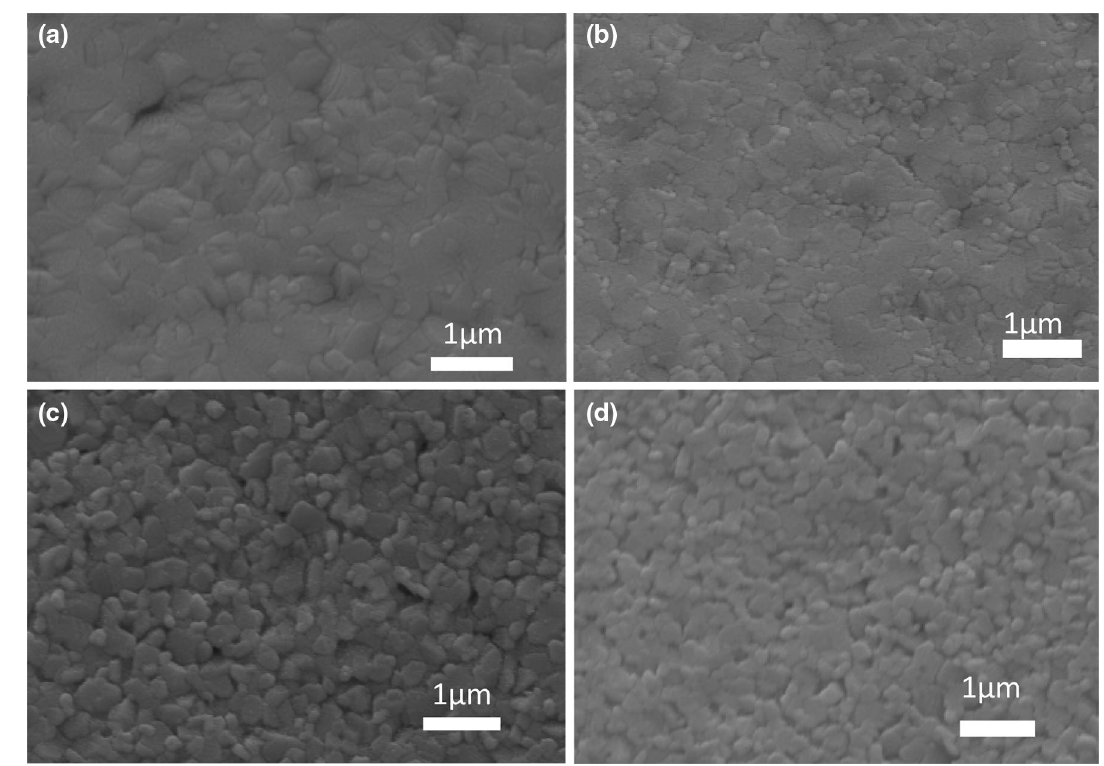
Fig. 2 Surface morphologies of perovskite films annealed at the temperatures of a 80 °C; b 85 °C; c 90 °C; and d 95 °C, respectively, for 5 min